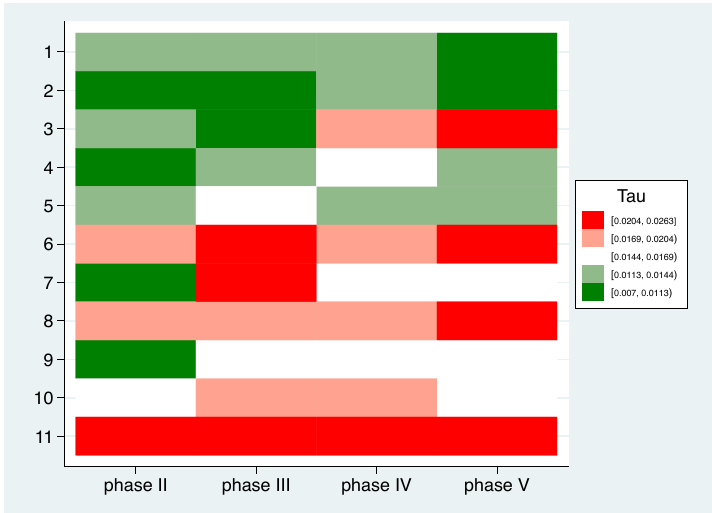
Figure 5. τ for all 11 participants acrosss phases II–V.